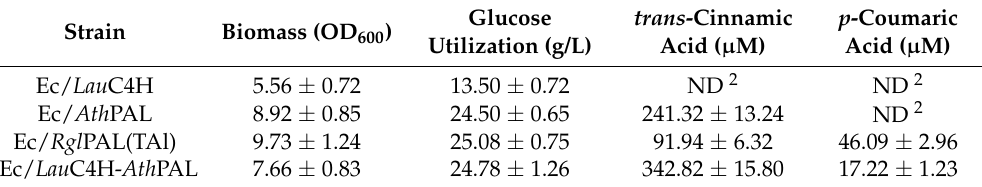
Table 1. p -Coumaric acid de novo biosynthesis using Lau C4H in E. coli . 1